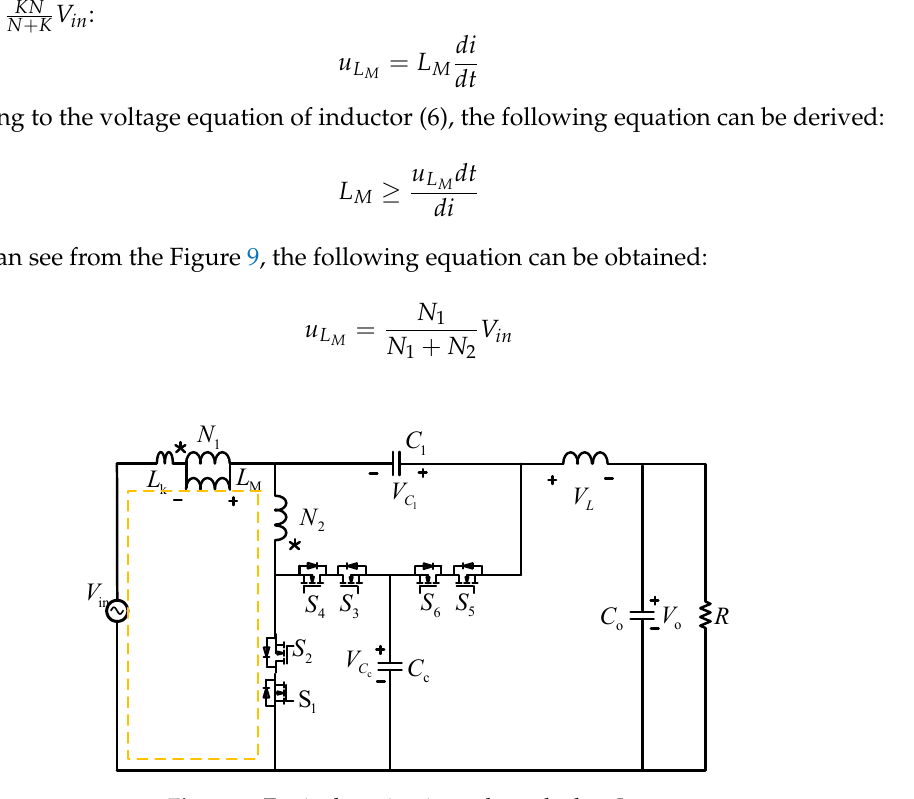
Figure 9. Equivalent circuit used to calculate L M.